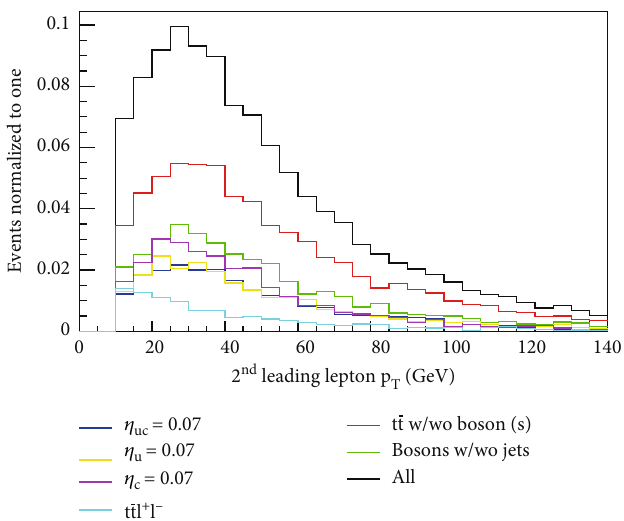
Figure 8: p distribution of signal and background processes for secondary leading leptons. T